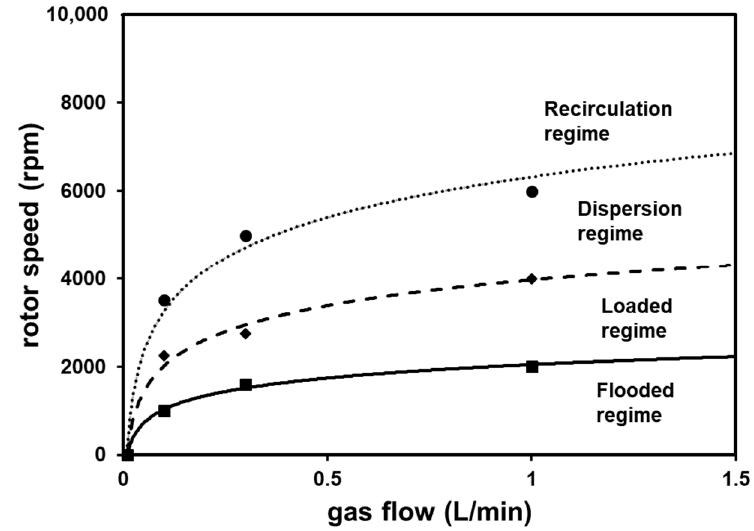
Figure 4. Effect of gas flow rate and rotor speed on the bubble dispersion during HSMC in water. Diagram predicted using the data published in previous studies [24,31,40].